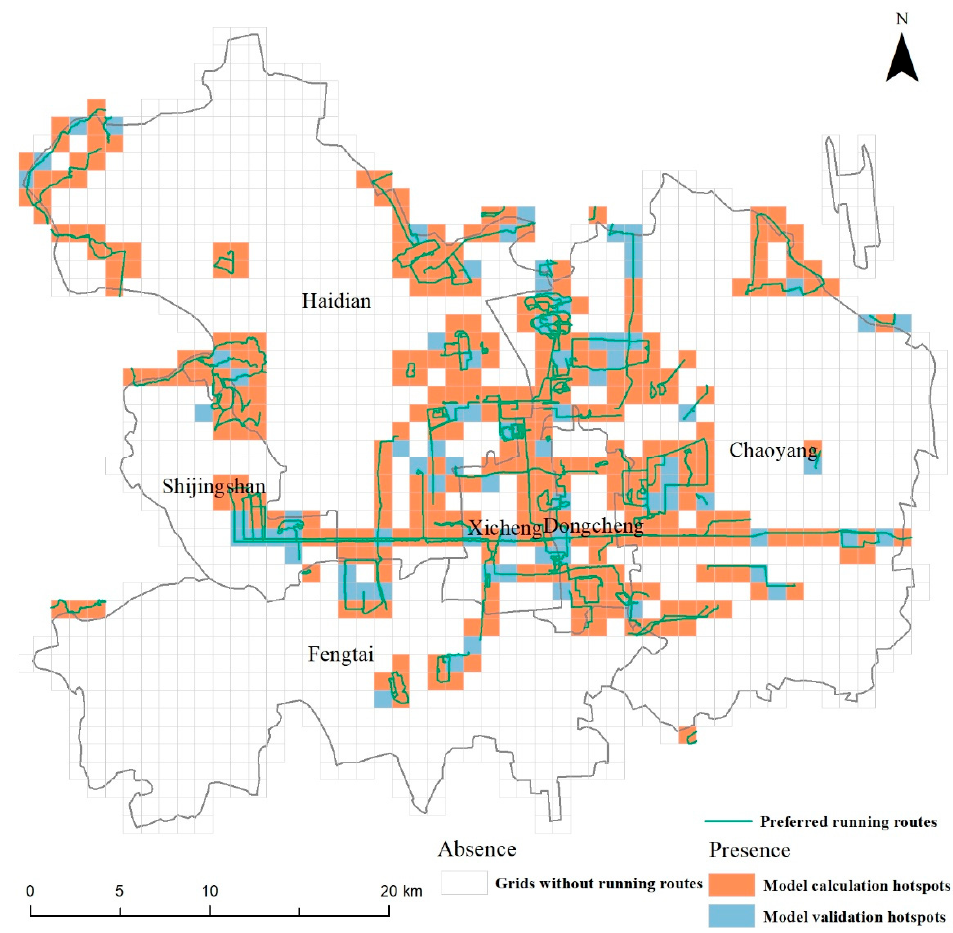
Figure 2. The distribution map of running routes.